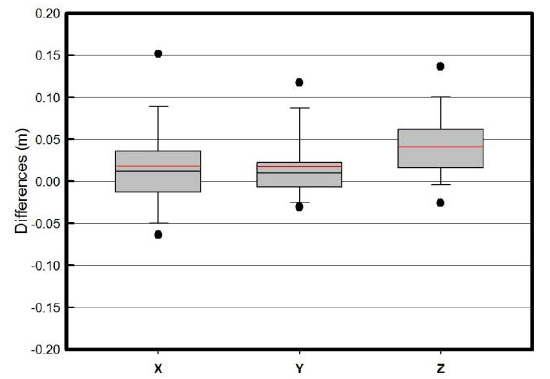
Figure 4. Differences of the CTP-GPSNet™